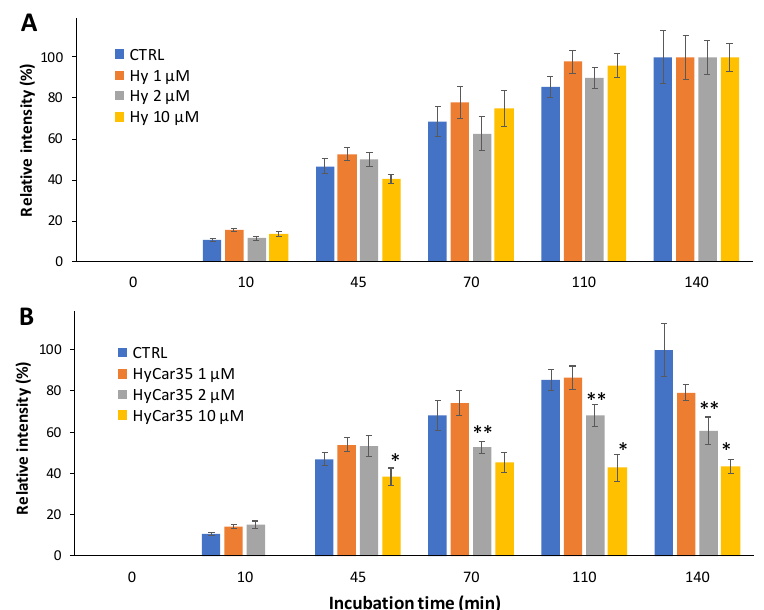
Figure 6. Time-dependent formation of the ACR-reporter adduct (1:1) in the absence (CTRL) and in the presence Hy ( A ) or HyCar ( B ), the concentration of the latter ones ranging from 1 to 10 µM. (* p < 0.005 vs. HyCar35 2 µM; ** p < 0.005 vs. HyCar35 1 µM).